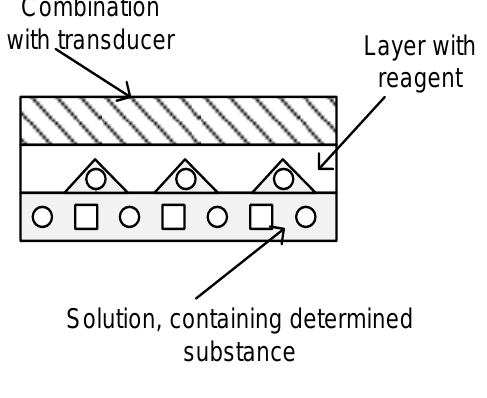
Fig. 1. Biosensor scheme